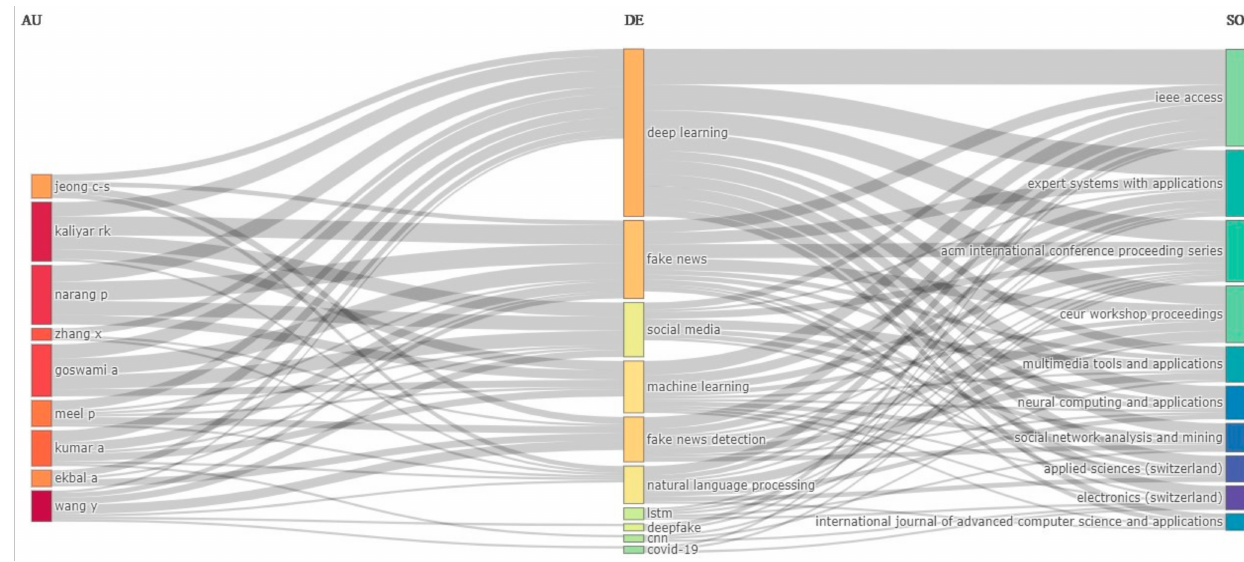
Figure 7. Three-field plot.